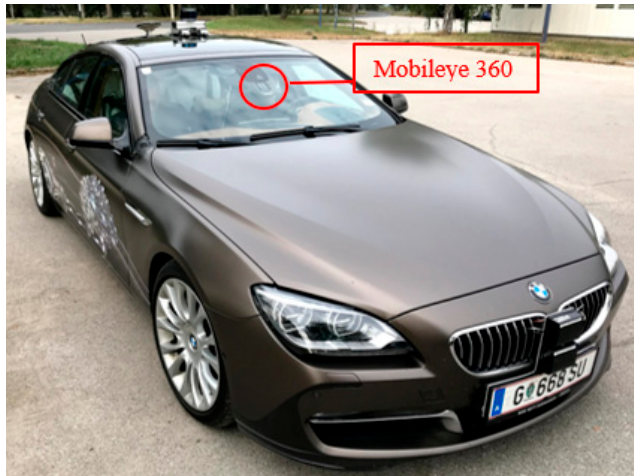
Figure 1. Testing vehicle with Mobileye 360 implemented behind the front windshield inside the vehicle.